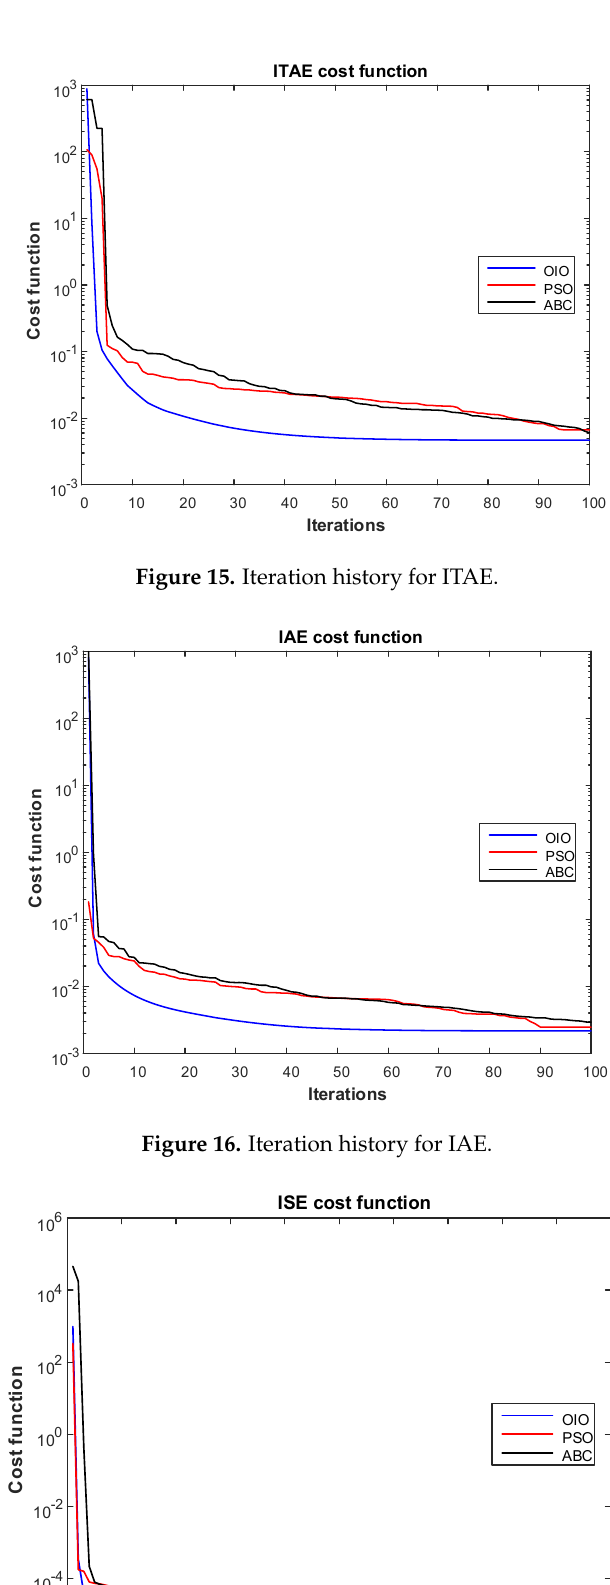
Figure 17. Iteration history for ISE.